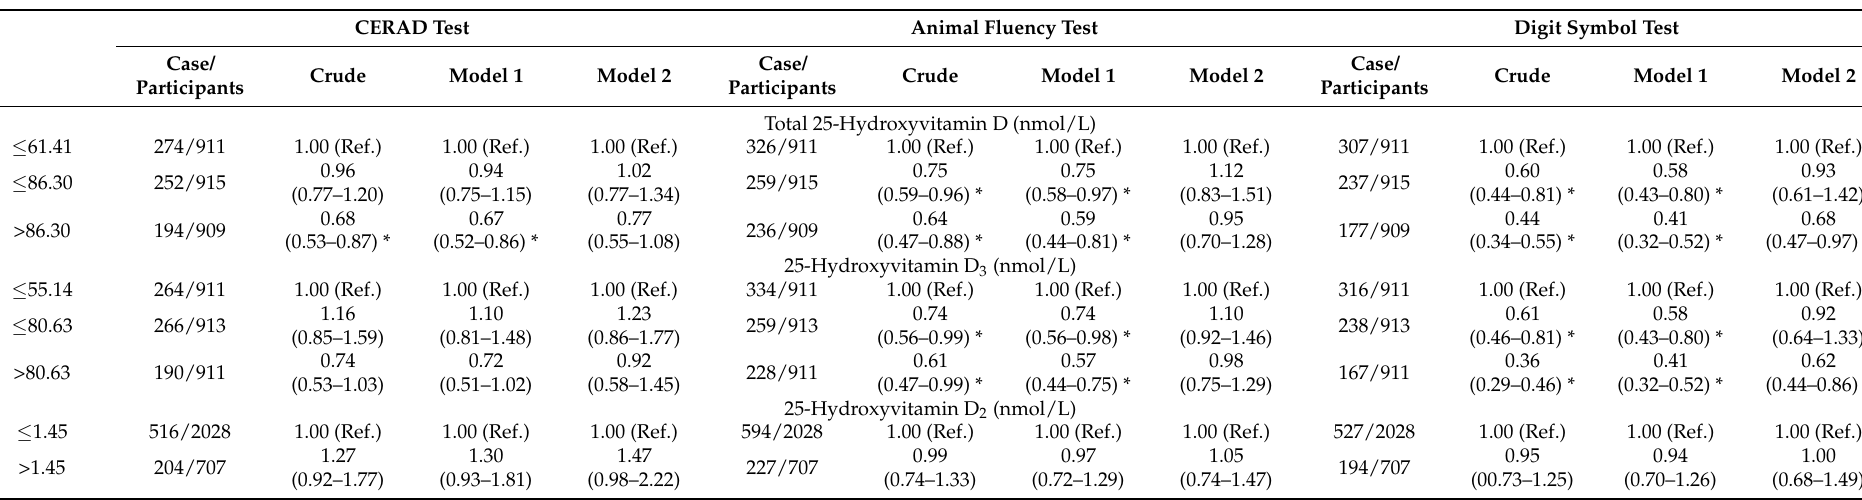
Binary logistic regression analyses were used to calculate weighted OR values. Reference (Ref.); model 1 adjusted for age and gender; model 2 adjusted for age and gender, race, educational level, marital status, income, body mass index (BMI), season of exam, physical activity level, drinking status, smoking status, hypertension, diabetes, and stroke. Energy was adjusted when we studied the intake of dietary VD. * p -value ≤